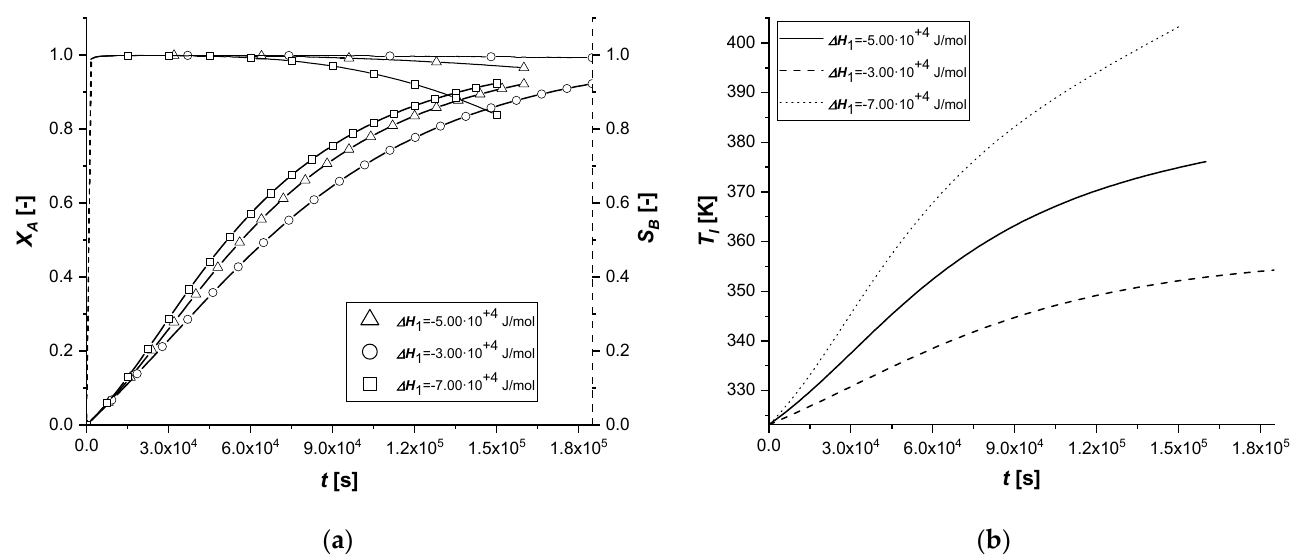
Figure 7. EY Δ rH 1 investigation. ( a ) Bulk profiles over time of X A and S B . ( b ) Bulk profile of T l over time.